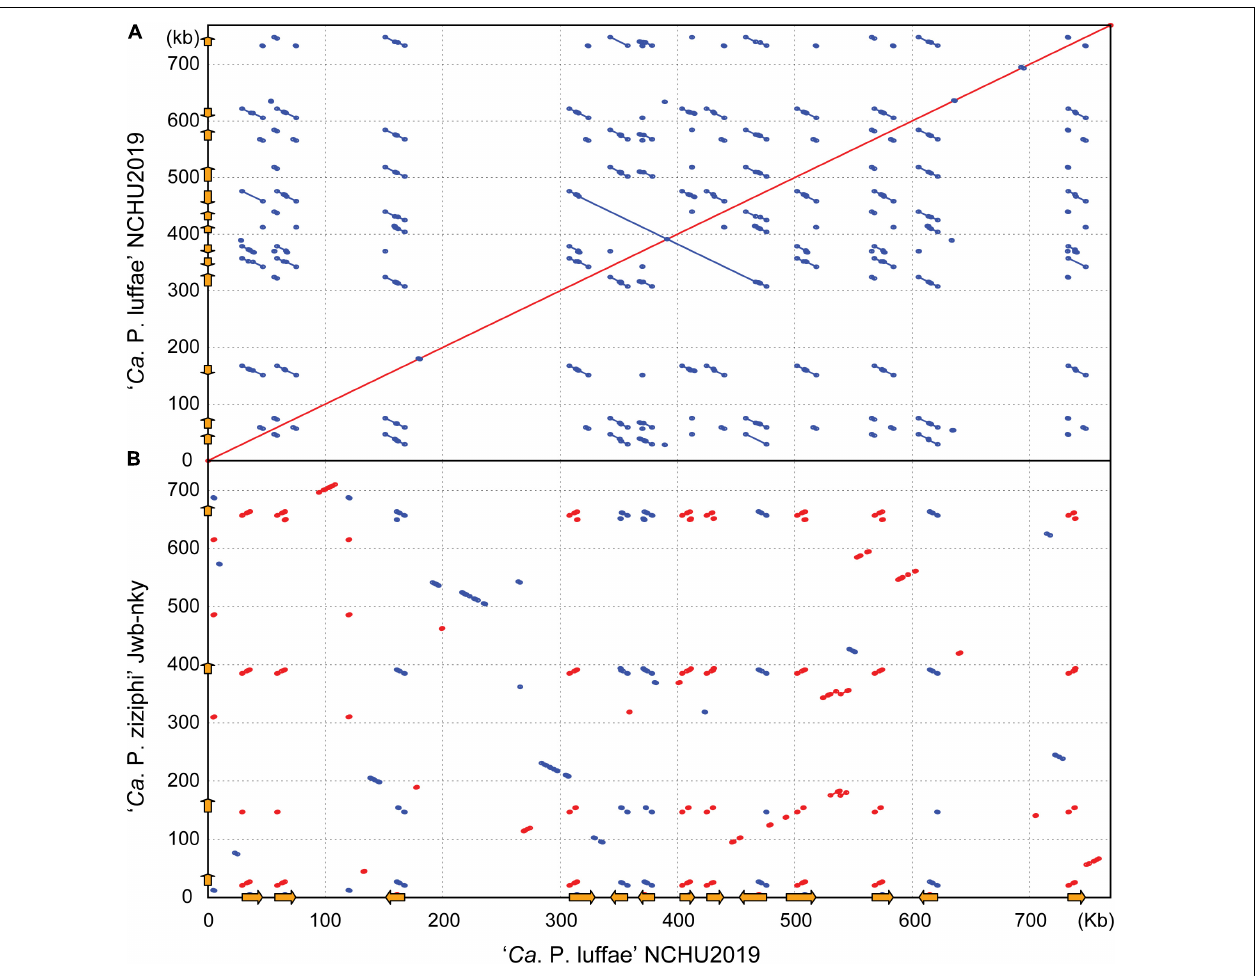
FIGURE 4 | Pairwise genome alignments. The genome of ‘ Ca . P. luffae’ NCHU2019 was used as the reference for comparison with (A) itself and (B) ‘ Ca . P. ziziphi’ Jwb-nky. Matches on the same strand and the opposite strand are indicated in red and blue, respectively. Potential mobile units (PMUs) are illustrated as orange arrows on both